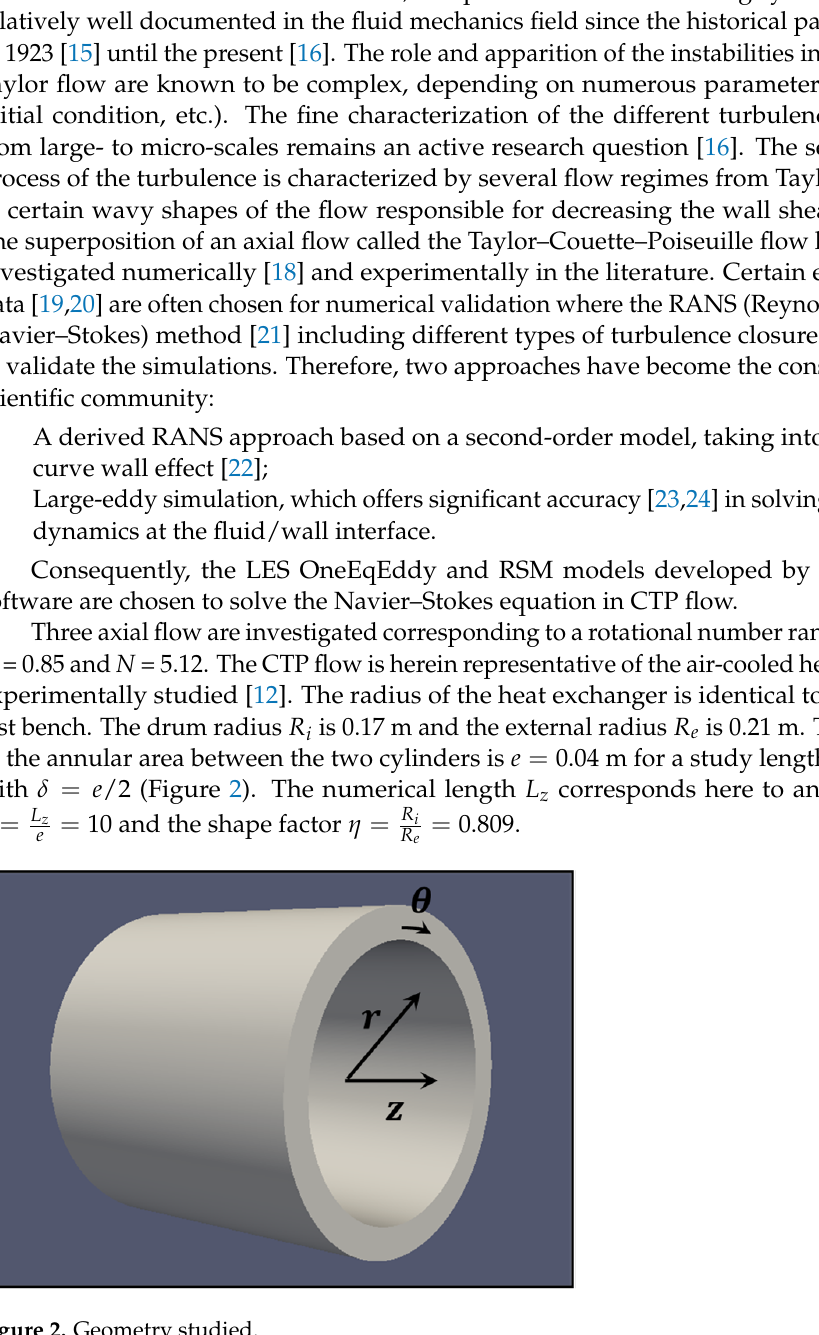
Figure 2. Geometry studied. The considered fluid is air (density: ρ = 1.2 kg.m 3 , dynamic viscosity: µ = 1.85 × 10 − 5 kg.m − 1 .s − 1 ). The rotational speed of the drum is equal to 50 tr.min −